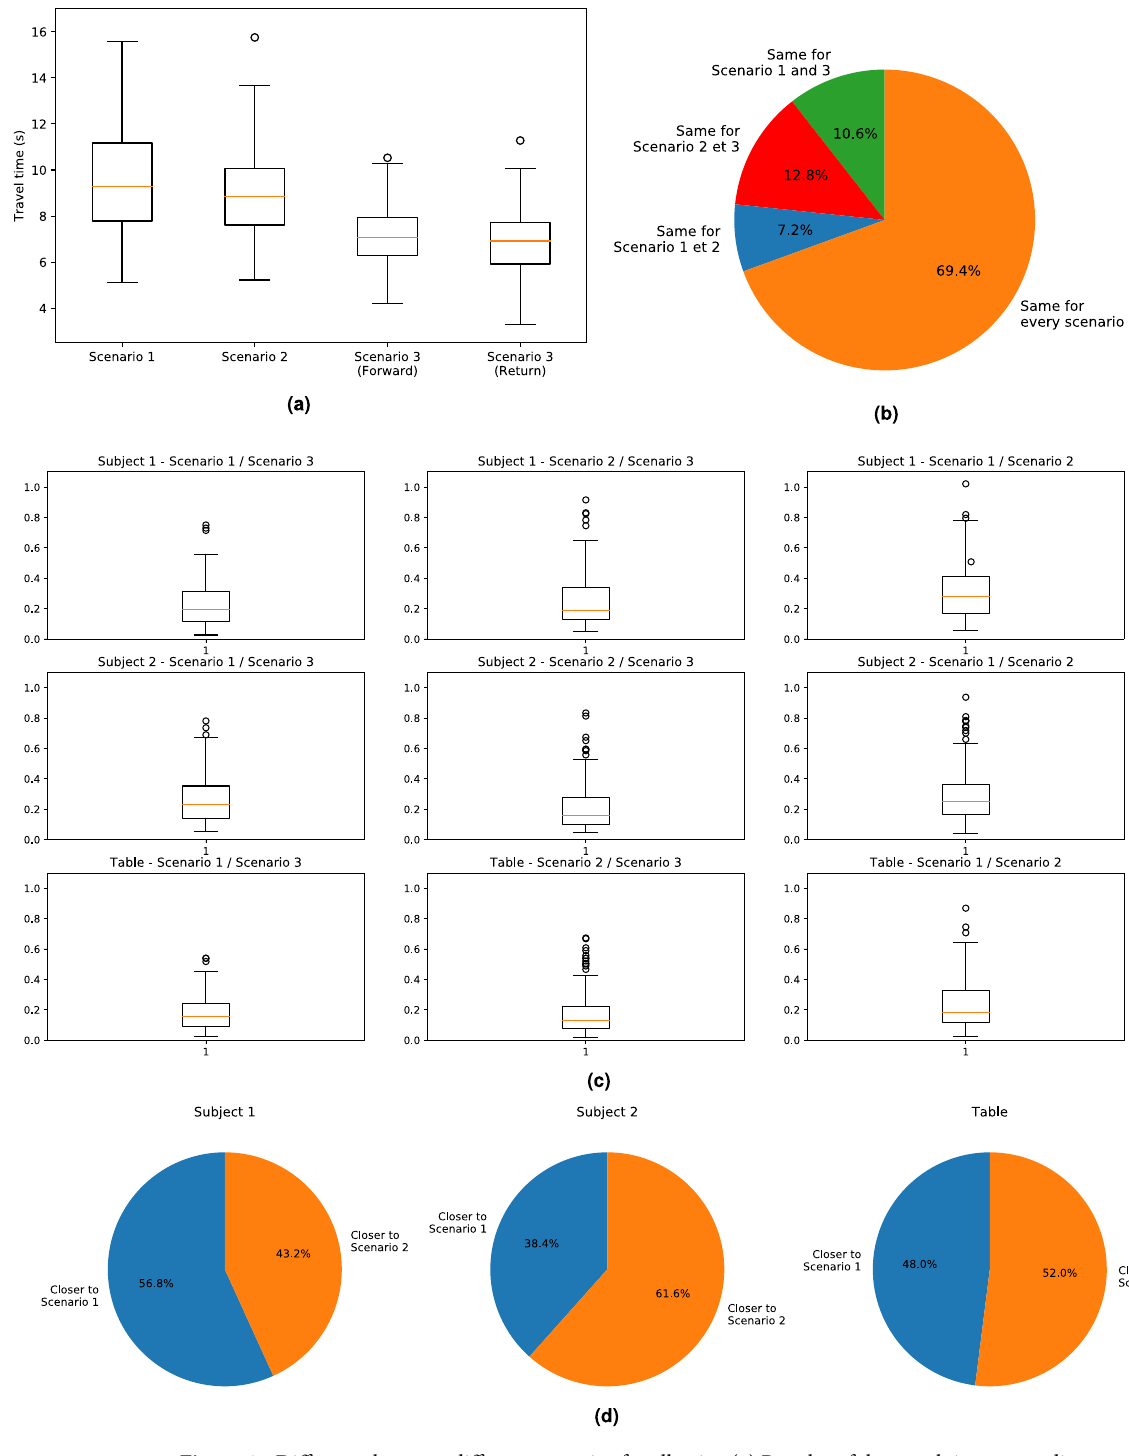
Figure 4. Difference between different scenarios for all pairs. ( a ) Boxplot of the travel times according to the different scenarios. ForScenario 3, the boxplots for the forward and return paths were split in order to determine if the pairs move faster or slower during the forward path or thereturn path. ( b ) At the end of each forward path, every pair laid the table in the configuration they chose. This pie chart shows the percentage of experiments where the pairs put the table in the same configuration during Scenario 1 and 3 but not during 2 (green), where they put it in thesame configuration during Scenario 2 and 3 but not during 1 (red), where they put it in the same configuration during Scenario 1 and 2 butnot during 3 (blue) and where they always put it in the same configuration during the three scenarios (orange). ( c ) Boxplots of the linear distances (m) between the trajectories performed during Scenario 1 and 3 (on the left), Scenario 2 and 3 (in the middle) and Scenario1 and 2 (on the right) for Subject 1, Subject 2 and the table. ( d ) Closeness of the trajectory performed in the Scenario 3 with the two others according to the linear distance for Subject 1, Subject 2 and the